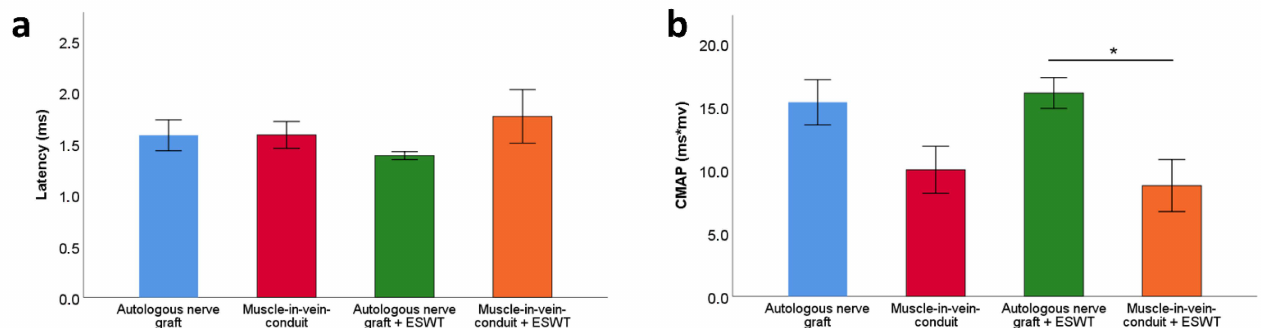
Figure 5. Distal motor latency ( a ) and compound muscle action potential area ( b ) of the reconstructed right median nerve 12 weeks following resection of a 7 mm segment of the right median nerve and immediate reconstruction with an autologous nerve graft ( n = 14), a muscle-in-vein conduit ( n = 11), an autologous nerve graft + ESWT (autologous nerve graft with postoperative extracorporeal shockwave therapy) ( n = 15) or a muscle-in-vein conduit + ESWT (muscle-in-vein conduit with postoperative extracorporeal shockwave therapy) ( n = 8). Results of the electrophysiological evaluations were compared between the groups with the nonparametric Kruskal–Wallis test and the Dunn–Bonferroni post hoc test. CMAP: compound muscle action potential; * p <